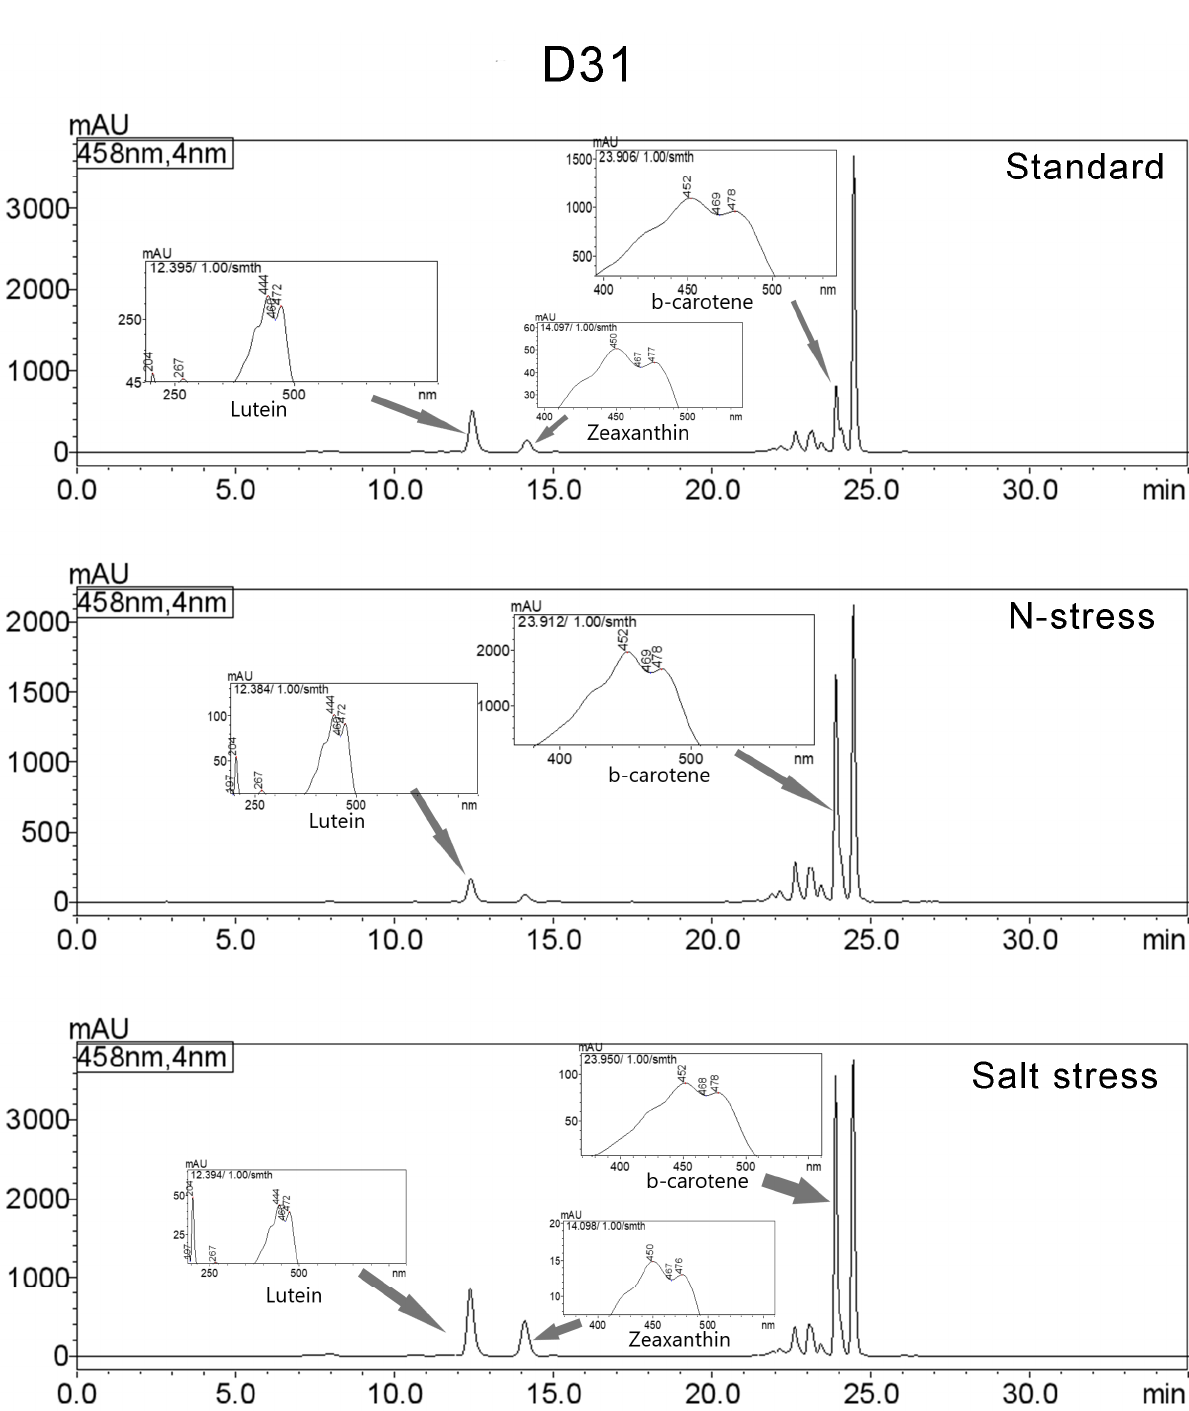
Figure 9. HPLC chromatographs of the Dunaliella salina AthU-Al D31 (D31) strain cultivated in standard conditions, under nitrogen deprivation (N-stress) and under high salinity (salt stress). Lutein, zeaxanthin and β -carotene peaks are marked on the chromatographs.